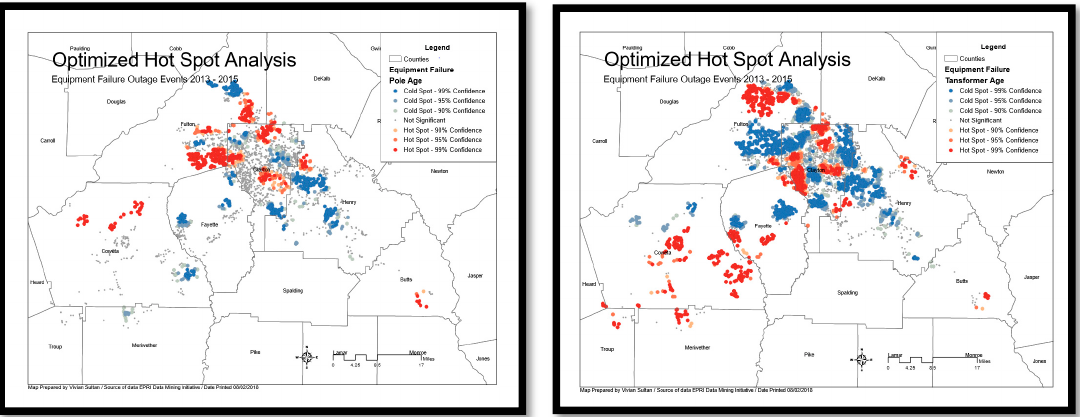
Figure 15. Spatial Analysis Level 3—Optimized Hot Spot Analysis output maps for each equipment failure type outage events. Left : pole age; right : transformer age.